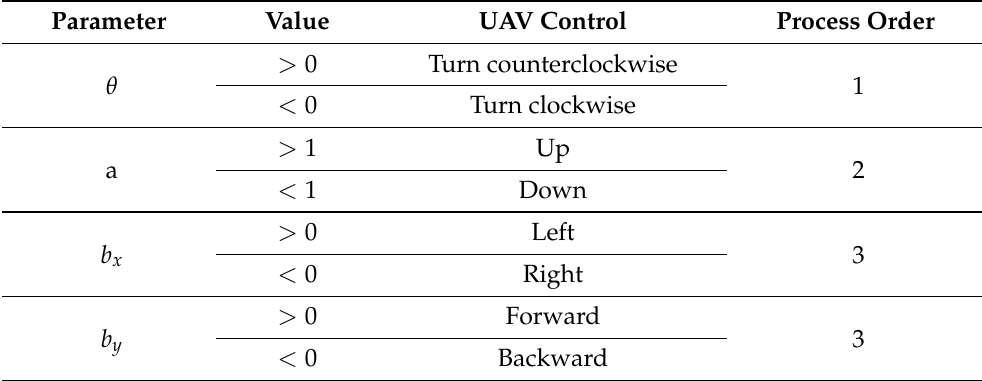
Table 2. First-order UAV control signal